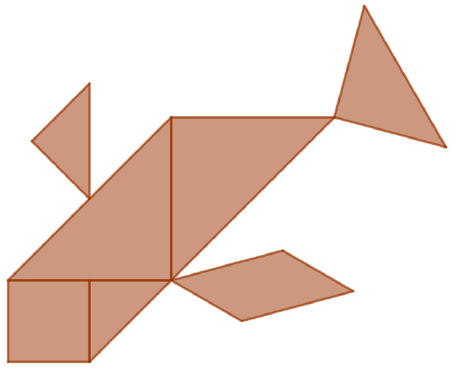
Figure 7. Assignment of Task 1.